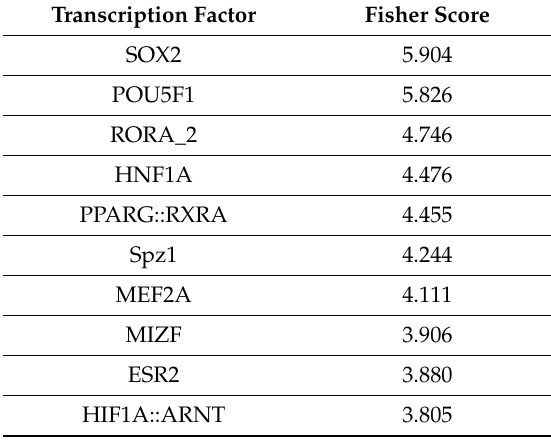
Table 6. The top 10 transcription factors (TFs) whose binding sites were enriched in the telomere- and telomerase-associated DEGs, ranked by Fisher score. The TFBS were identified by oPOSSUM